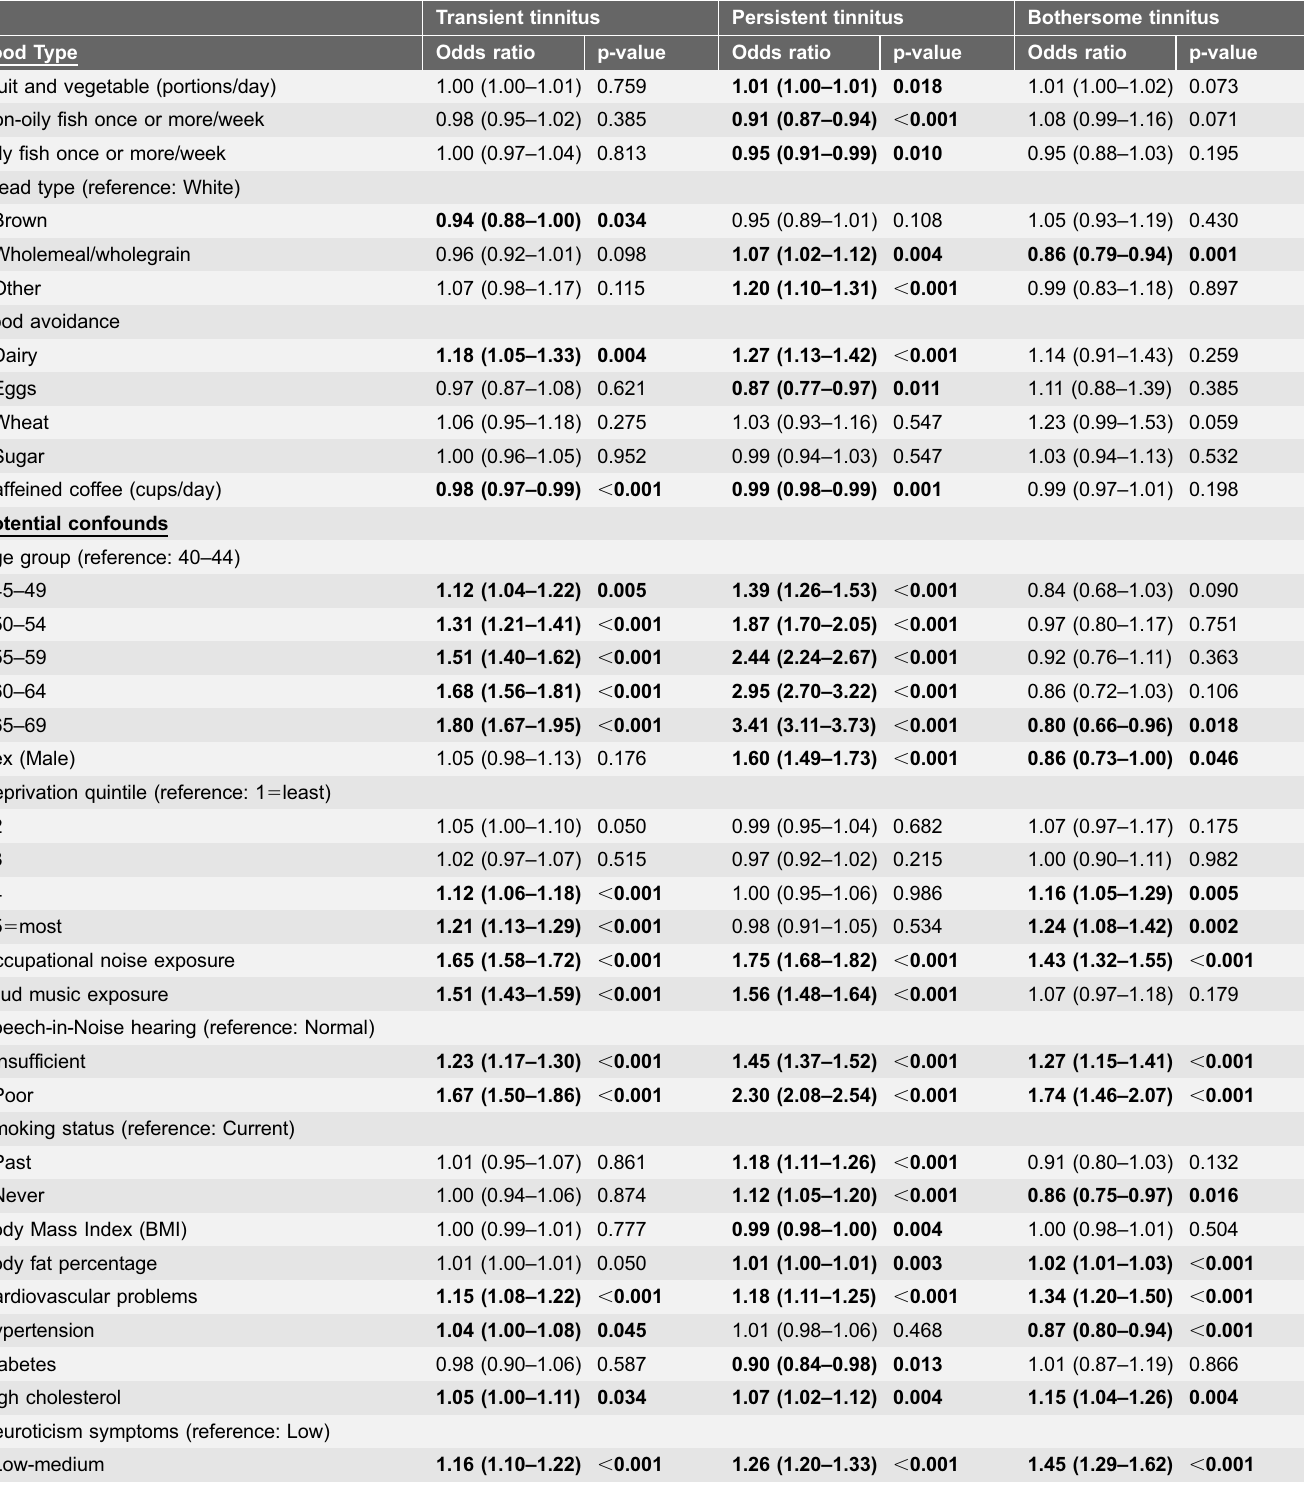
Table 2. Logistic regression of dietary factors predicting likelihood of